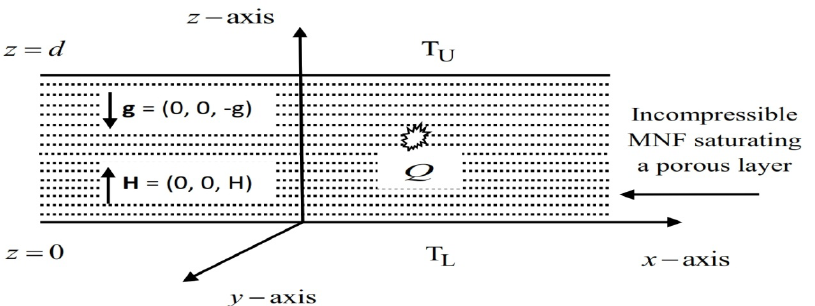
(ii) when lower boundary is impermeable and conducting while upper boundary is impermeable with constant heat flux (I_C-I_CHF), and (iii) when lower boundary is impermeable and conducting while upper boundary is free with constant heat flux (I_C-F_CHF). Moreover, the nanoparticle fraction is adjusted in a way such that the nanoparticle flux is zero on the boundaries. To derive the boundary conditions for nanoparticle volume fraction, the effect of both thermophoresis and magnetophoresis on the nanoparticle flux is taken into account. The results are calculated by using the Chebyshev pseudospectral method for two different configurations (i) when the layer is heated from below and (ii) when the layer is heated from above. The effects of several important parameters that affect the onset of instability are observed.